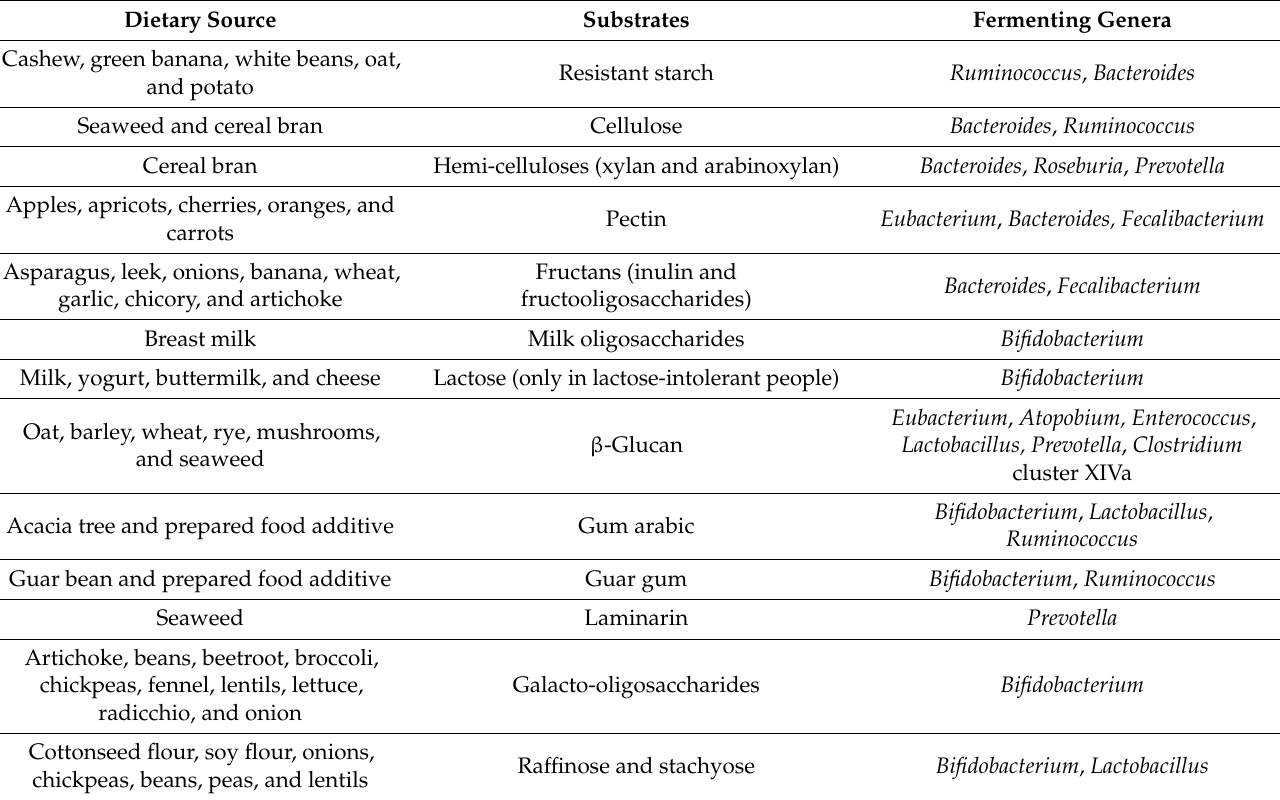
Table 3. Dietary source, fiber substrates, and SCFA-producing